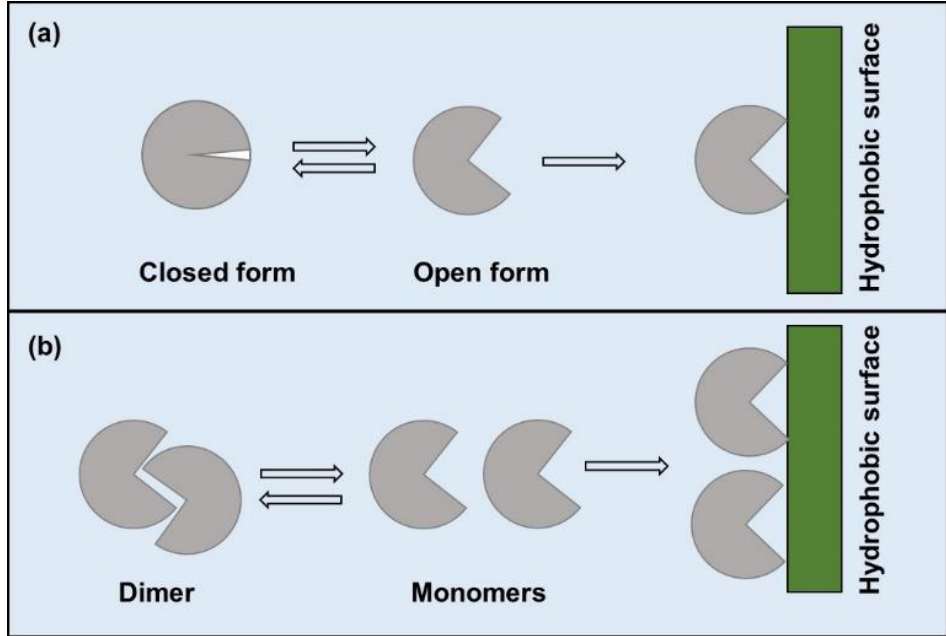
Figure 6. Equilibrium closed/open form ( a ) and dimer/monomer ( b ) of lipase in the presence of a hydrophobic surface. Table 2. Variation of activity and operational stability of C18-MSNs immobilized lipase with pore size. Pore Diameter (nm) Specific Activity with Respect to Soluble Enzyme